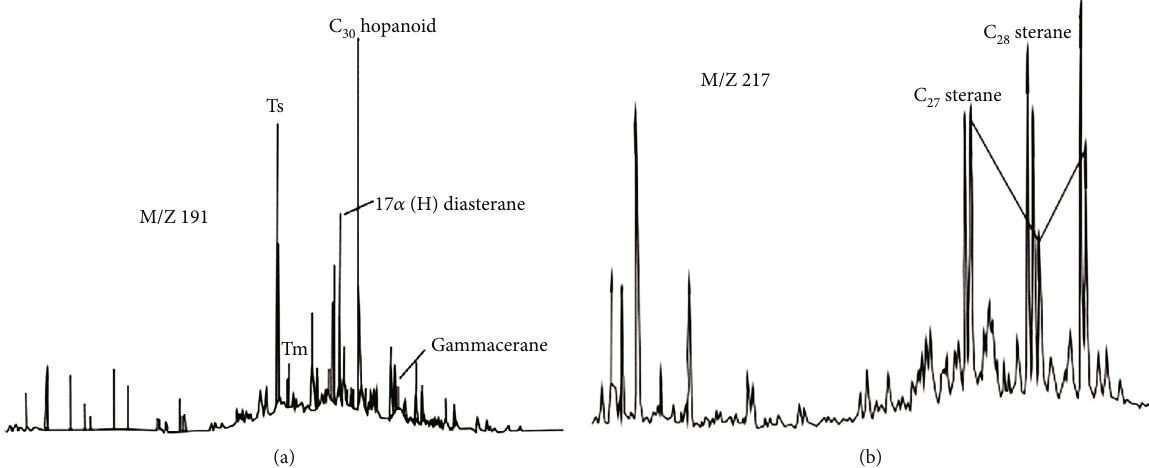
Figure 3: Characteristics of terpene hydrocarbon and sterane distribution of C7 source rocks of Dingtan3155 well in study area: (a) terpane; (b) sterane.